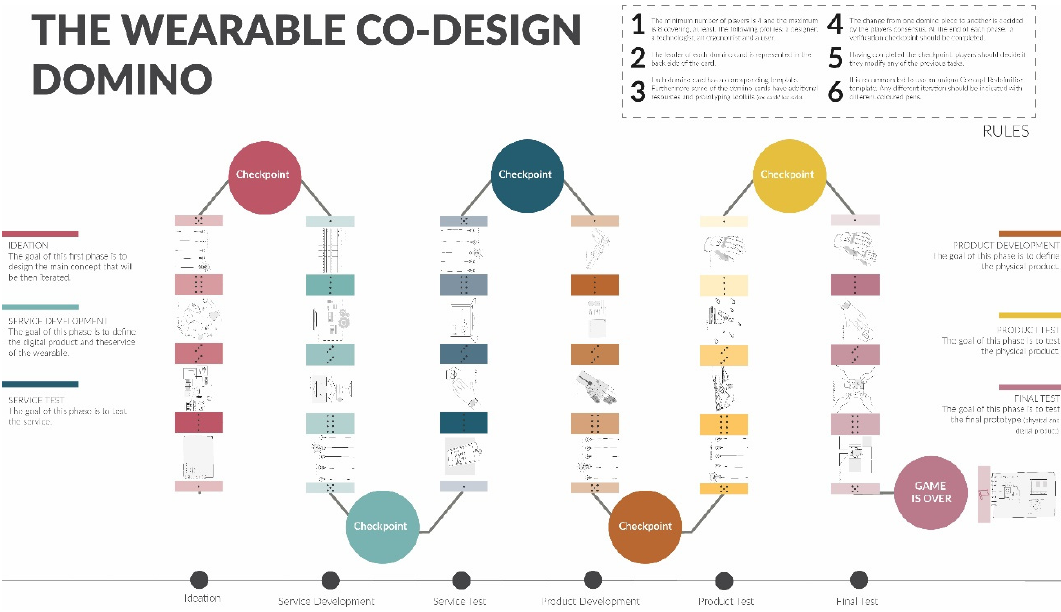
Figure 10. General view of The Wearable Co-Design Domino.